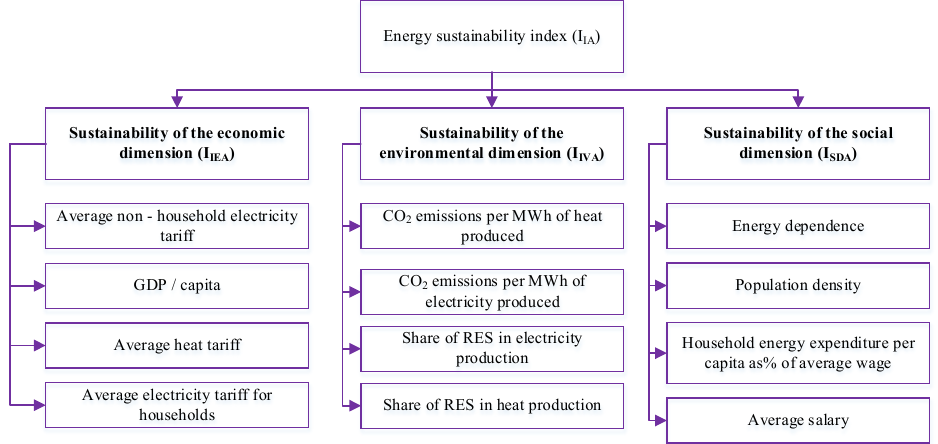
Fig. 1. Sustainable energy development